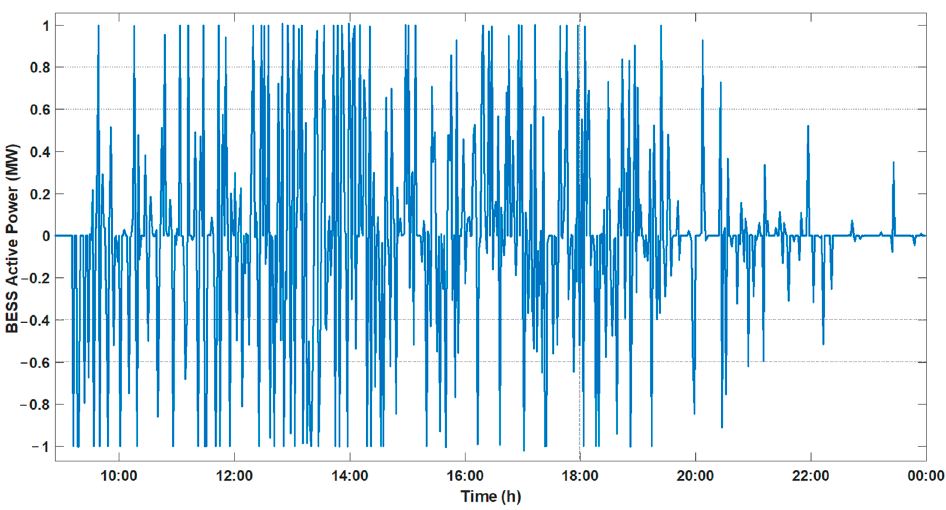
Figure 15. Total active power: power factor smoothing. Measurement performed on 19 October 2021.